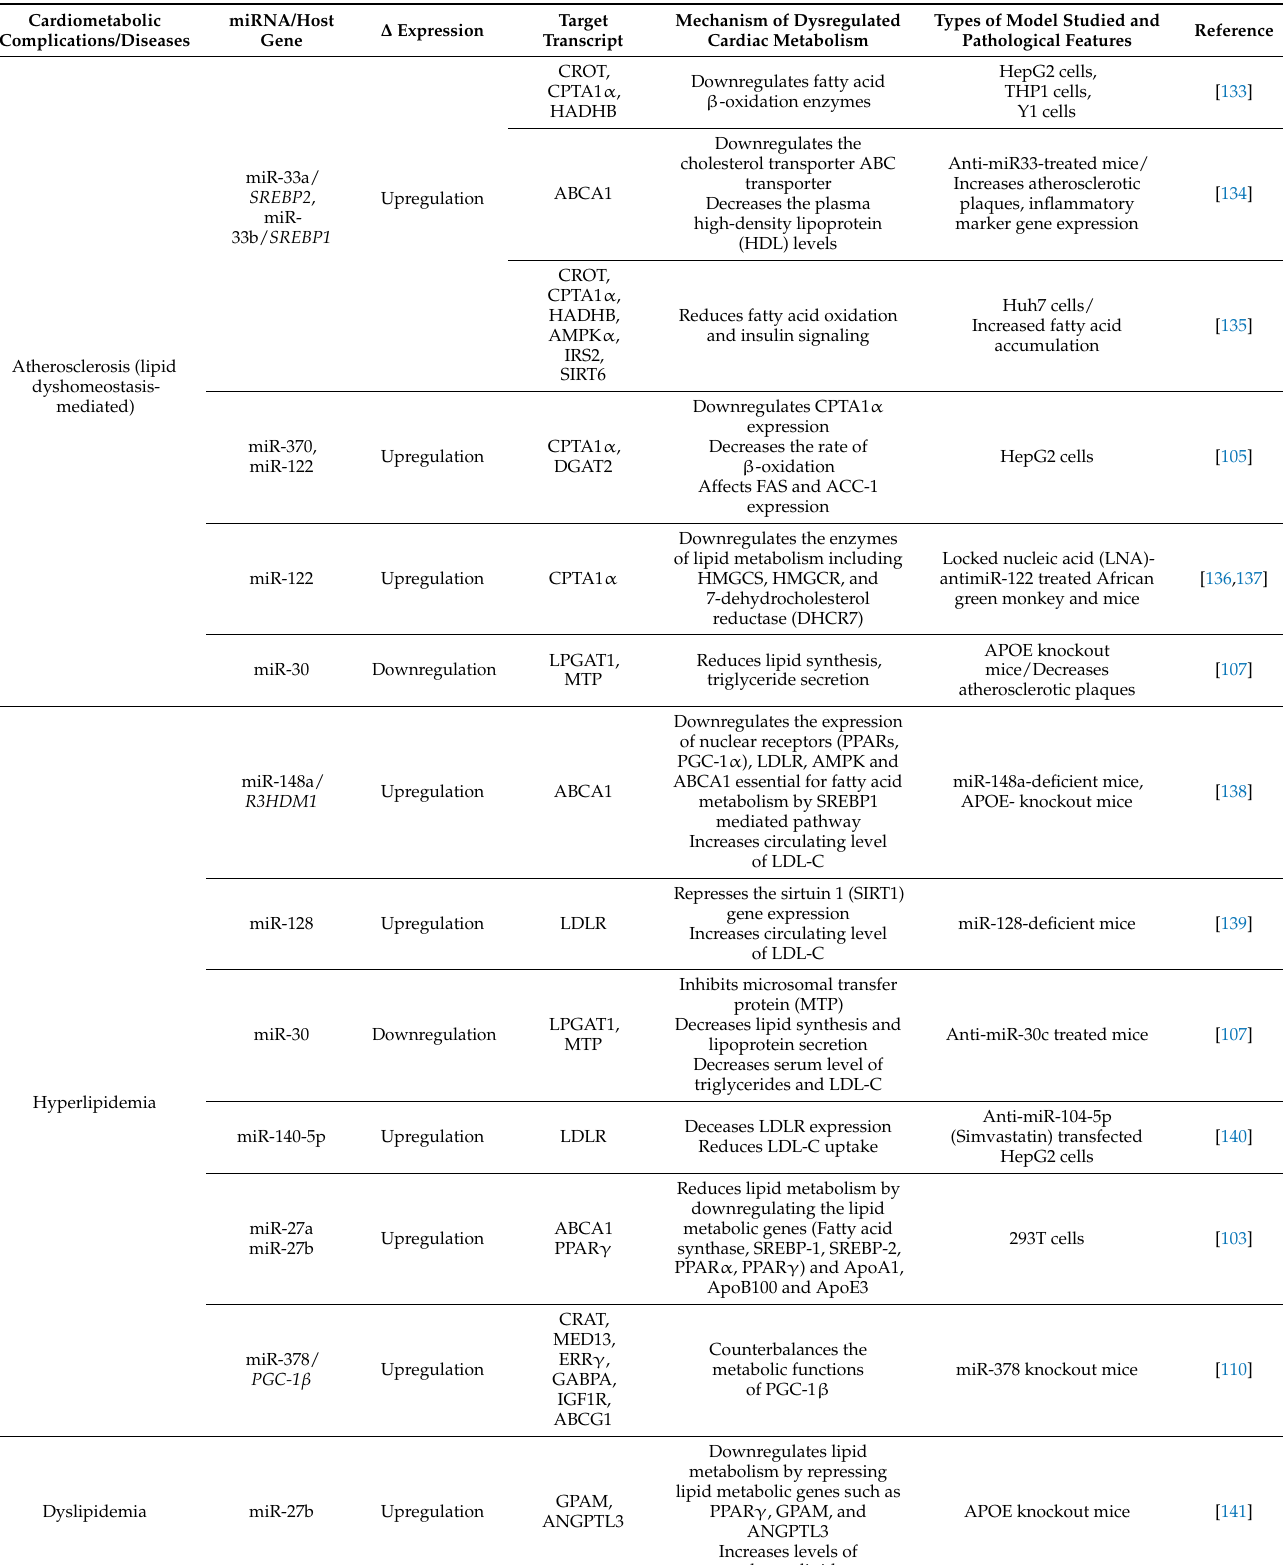
Table 1. Role of MiRNA in Cardiometabolic Disease/Complications by Dysregulated Cardiac